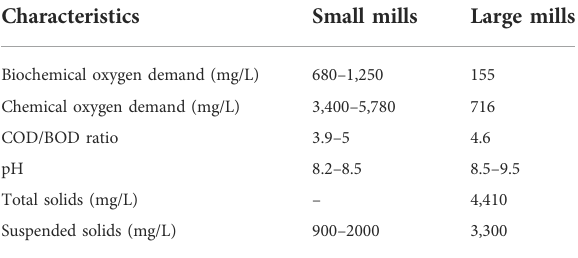
TABLE 2 Physical and chemical